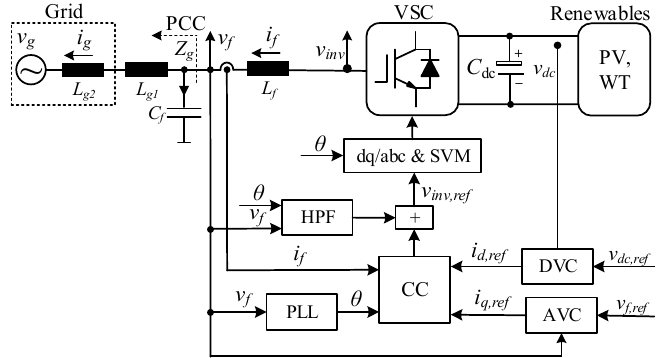
Figure 4. Single line diagram of a grid-connected three-phase voltage source converter (VSC).